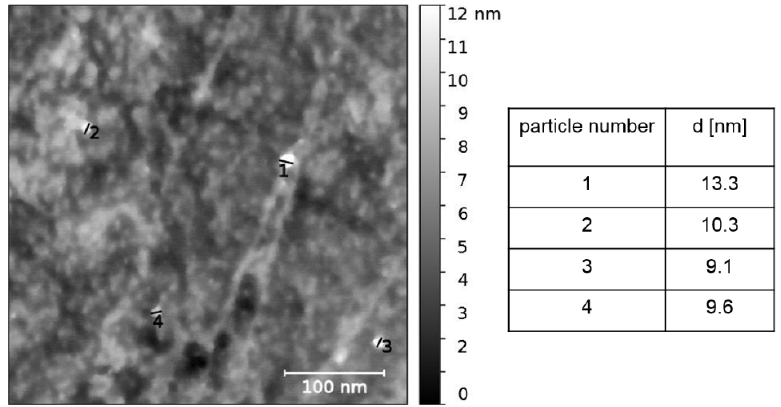
Figure 5. AFM map with very high resolution and four particles with their corresponding diameter.